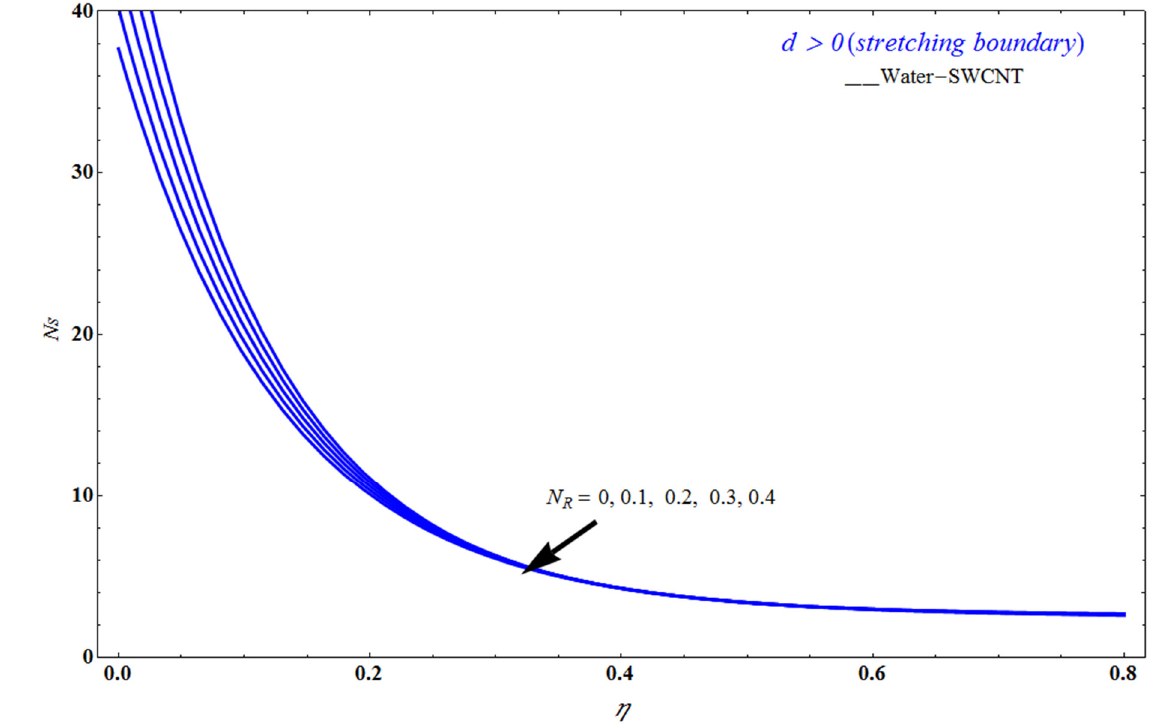
η for several values of R